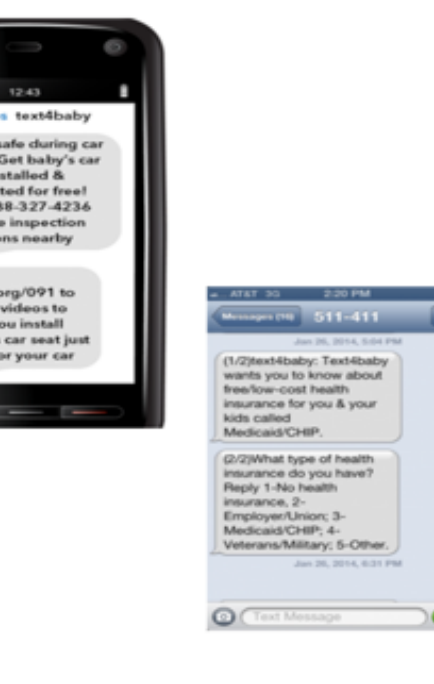
Figure 1. Screenshot of Text4baby